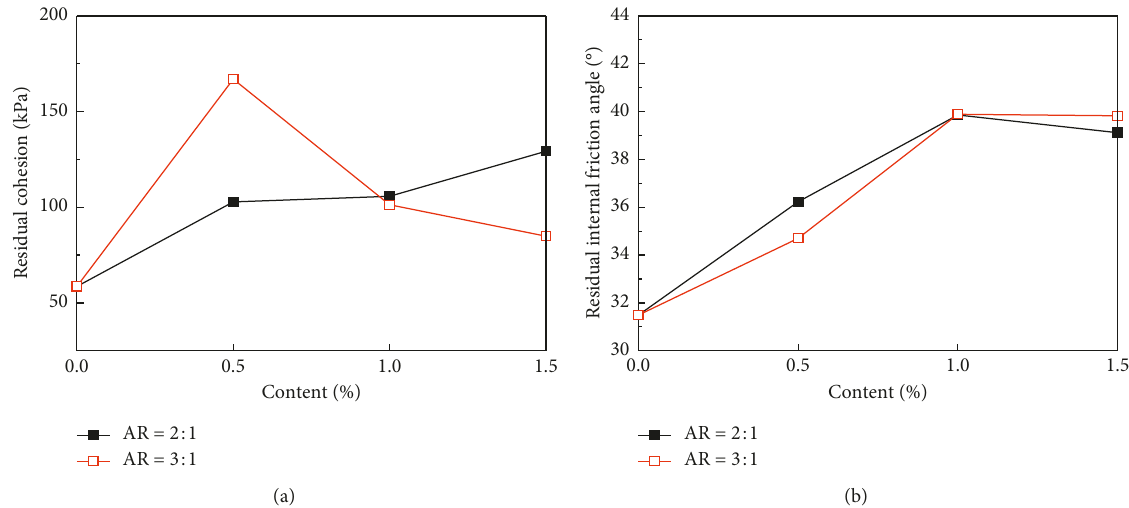
Figure 11: Variations in residual cohesion and residual internal friction angle under the effects of content and aspect ratio: (a) aspect ratio of 2:1; (b) aspect ratio of